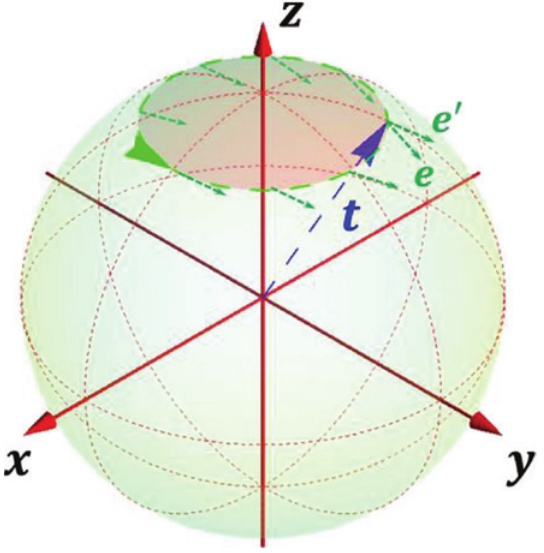
Figure 2: The parallel transport of the polarization vector e ⊥ t on the unit t -sphere in momentum space. For a loop trajectory, the polarization states rotate from e to state e ′.